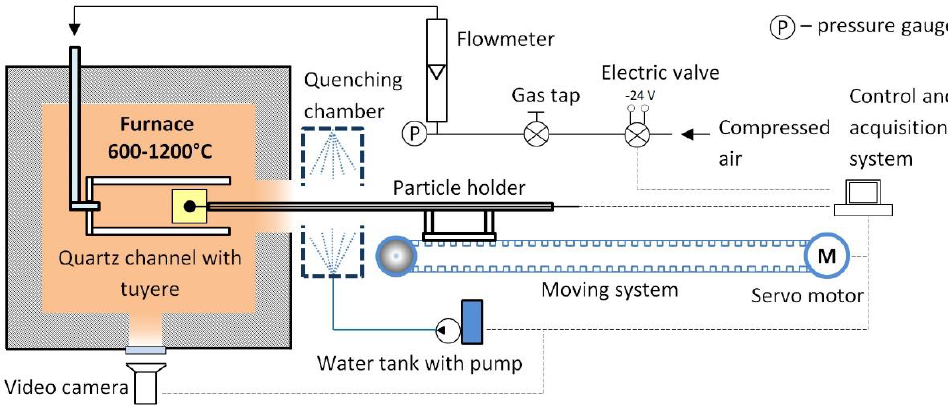
Figure 1. A schematic diagram of a rig for burning single fuel particles.